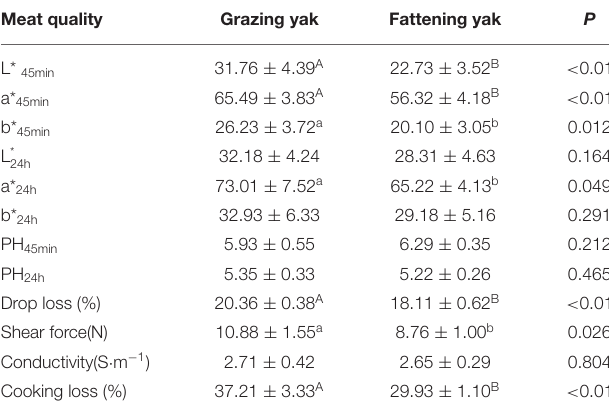
TABLE 2 | Effects of intensive fattening with TMR on the carcass characteristics of yak (mean ± SD). Carcass characteristics